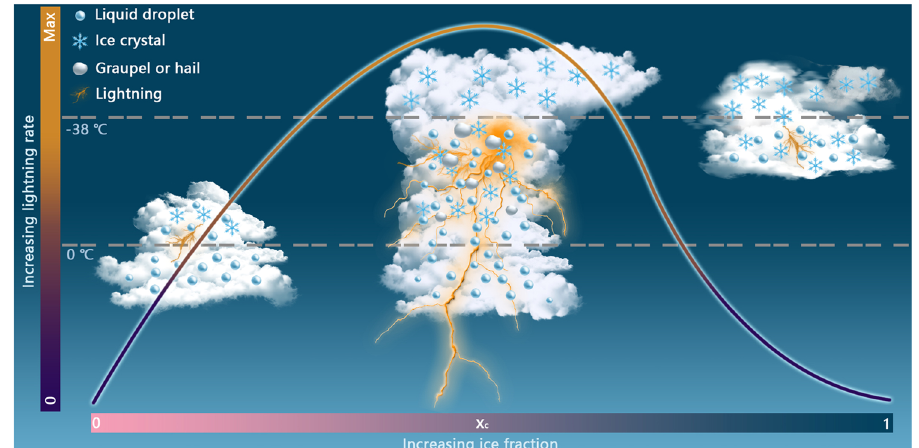
Fig. 5 Illustration of the effects of cloud ice fraction on the lightning activities. The three clouds from left to right represent Group-1, Group-2, and Group-3, respectively. Group-1, 2, and 3 are the thunderstorms with mostly liquid clouds, the thunderstorms with strong lightning density, and the thunderstorms with mostly ice clouds, respectively. The curve indicates the modi fi ed gamma function, which parameterizes the relationship between the lightning fl ash rate and the cloud ice